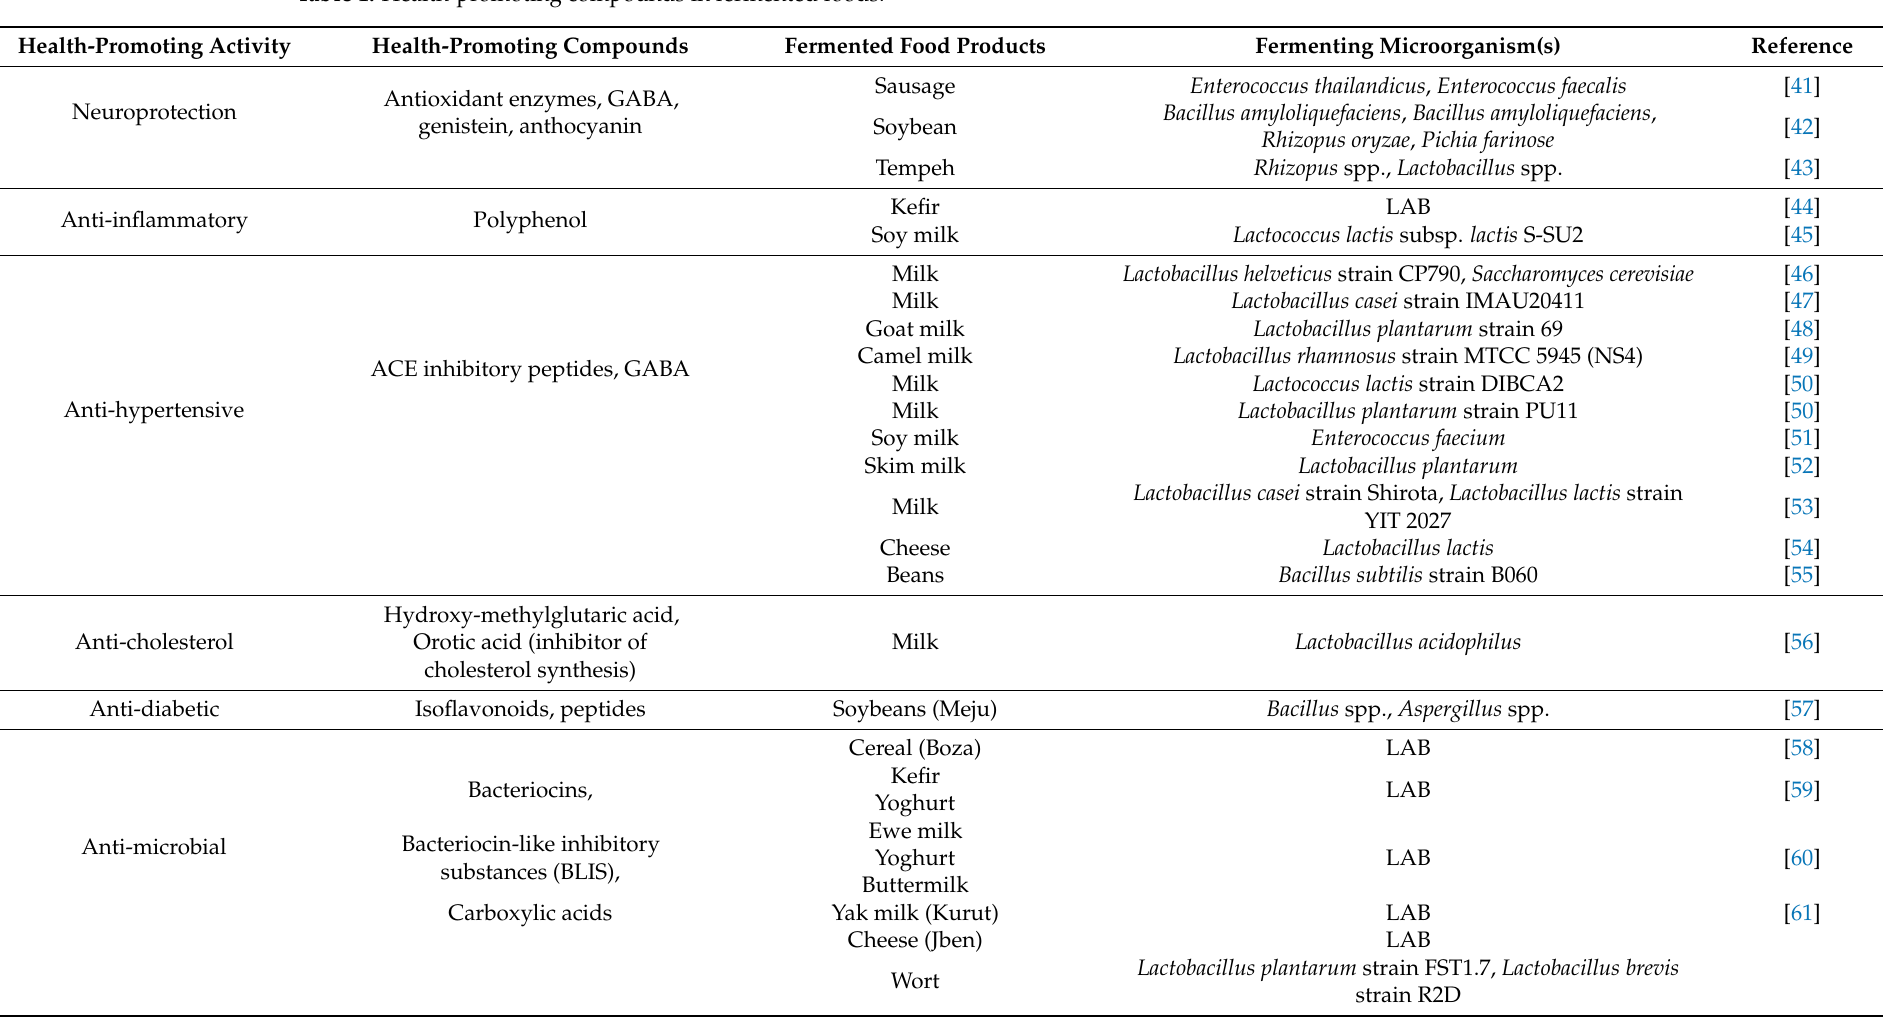
Table 1. Health-promoting compounds in fermented